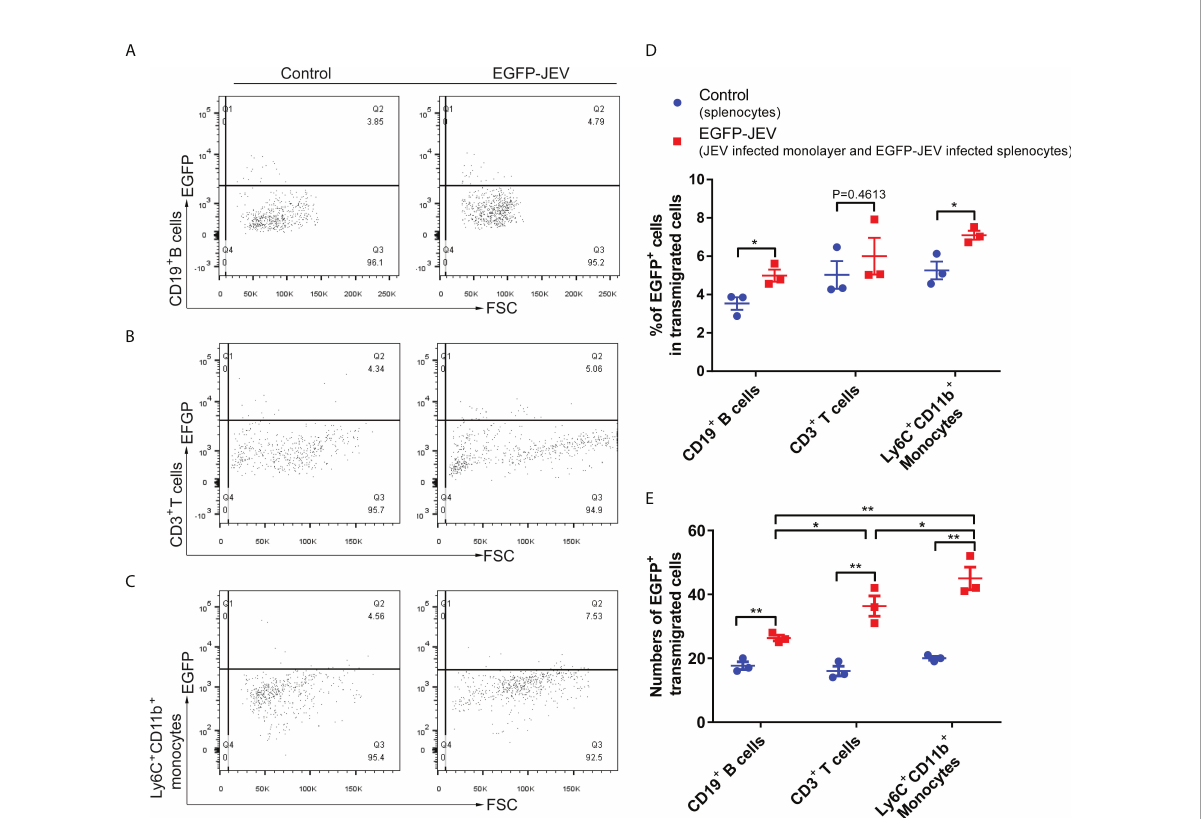
FIGURE 5 Virus-carrying splenocyte transmigration in vitro. (A – C) JEV-infected bEnd.3 cell monolayers were cocultured with EGFP-JEV-infected splenocytes (5 × 105) for 24 h, and the transmigrated cells (lower chamber) were collected and measured by fl ow cytometry. An enhanced sensitivity measure at 488 nm was performed for the detection of intracellular EGFP-JEV in CD19+ B cells, CD3+ T cells, and Ly6C+ CD11b+ monocytes by fl ow cytometry. EGFP-JEV free cells were the nonspeci fi c control. (D, E) The statistical analysis of EGFP-positive cells in the transmigrated cells in the lower chamber reported in (A – C) . The experiments were repeated at least three times. The data are expressed as the means ± SEM. p > 0.05 (ns, no signi fi cant difference), *p < 0.05 and **p <